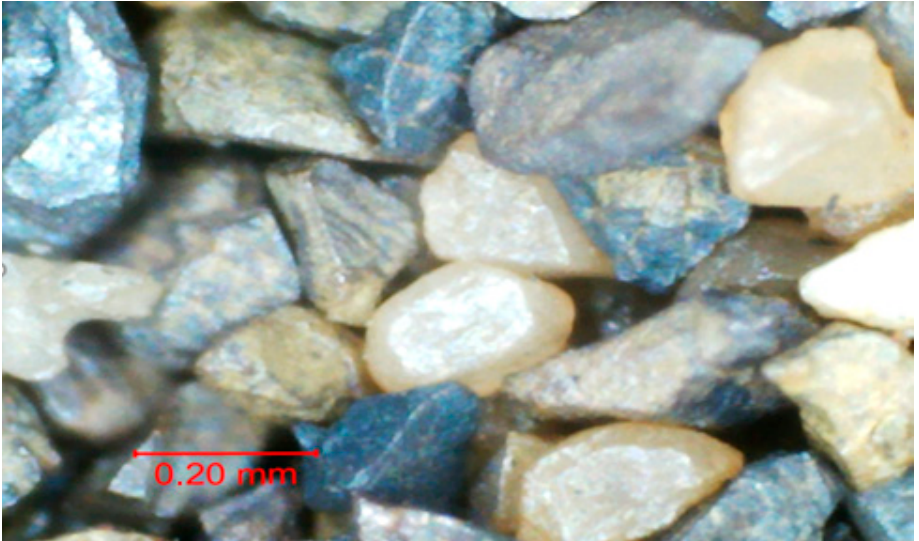
Figure 2. The microscopic photograph of ilmenite.